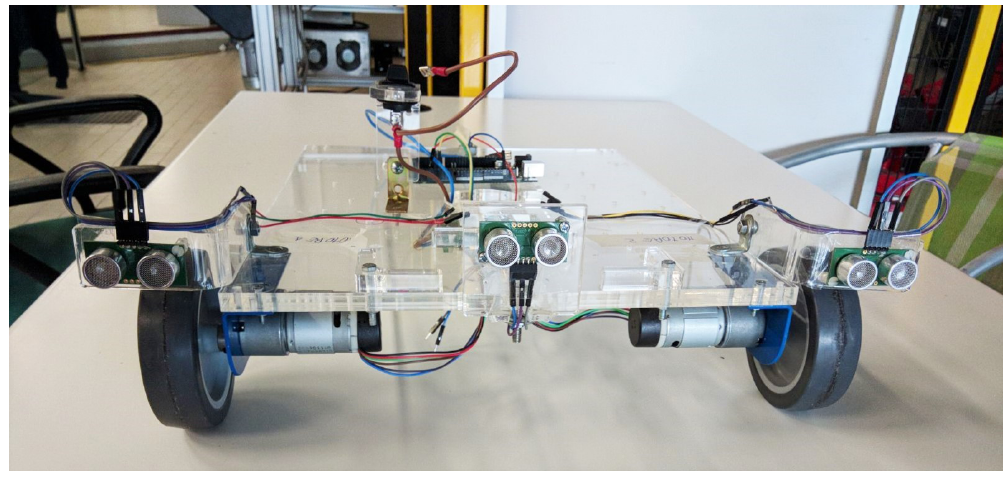
Figure 2. The wheeled mobile